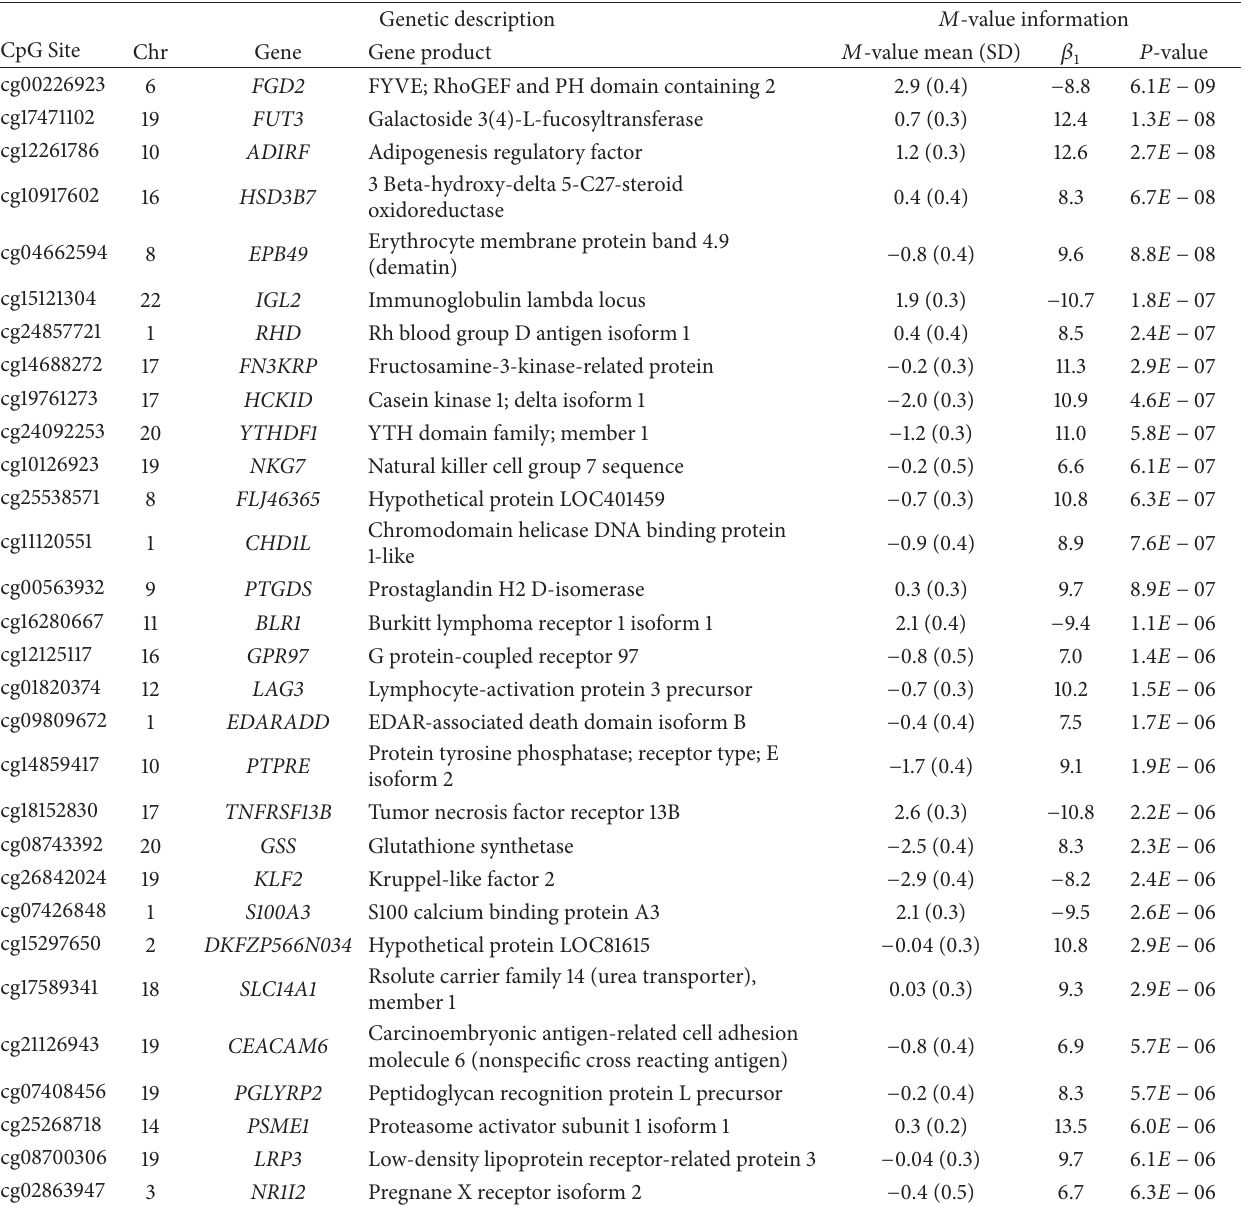
Table 2: Top 30 CpG sites most strongly associated with eGFR (Model